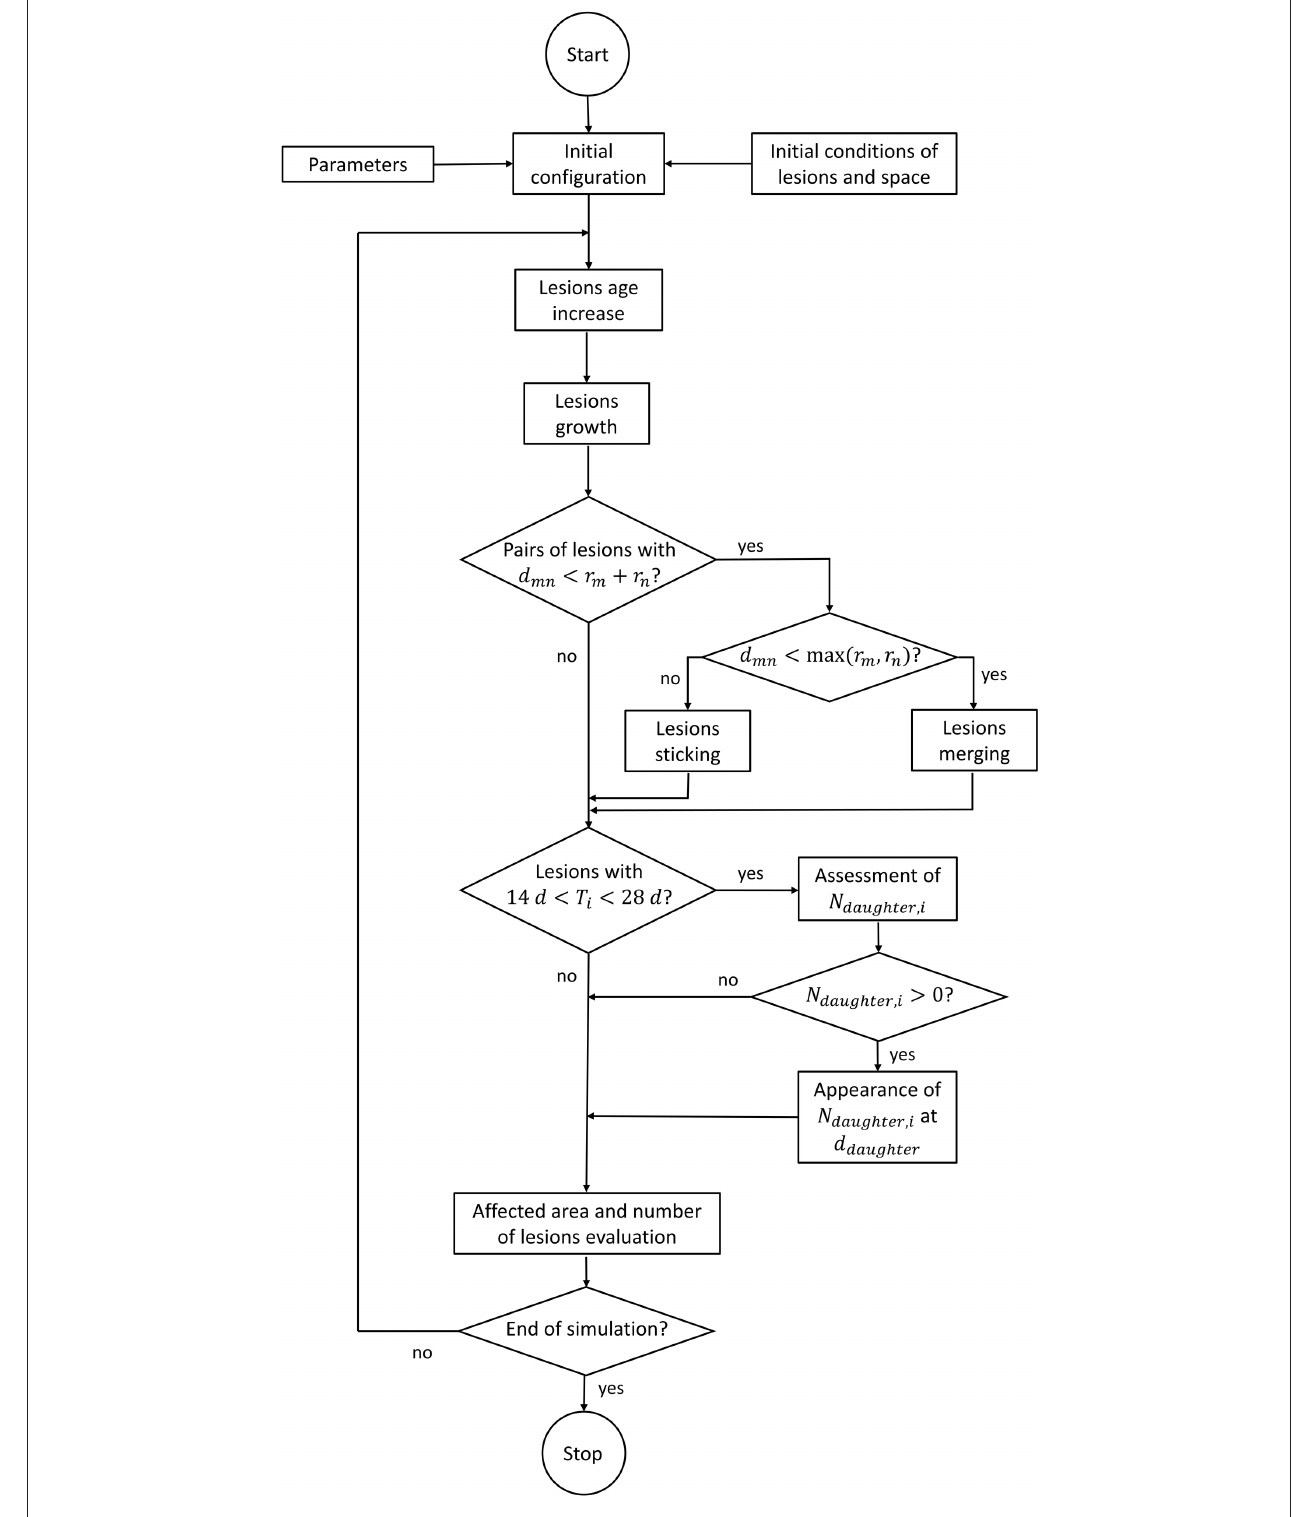
FIGURE 2 | Flow chart of the computer